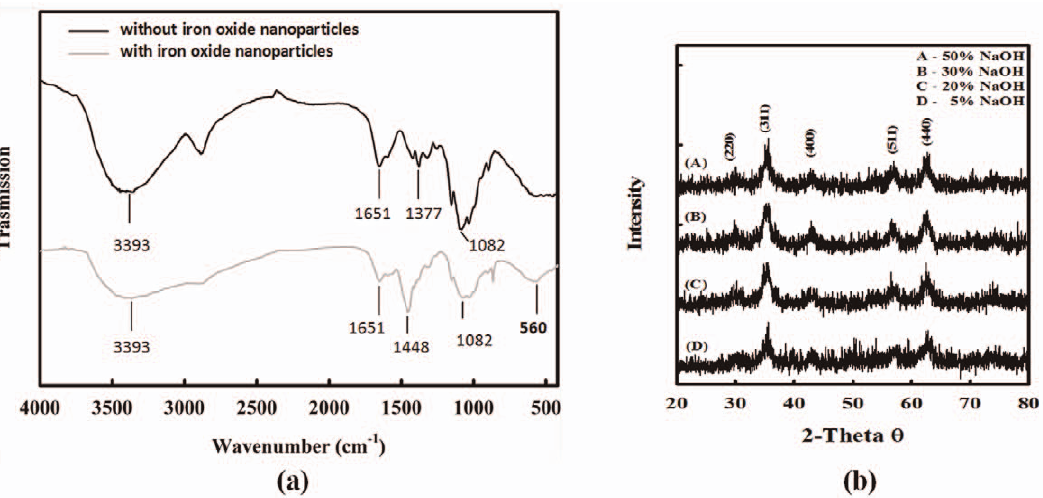
Figure 3. Characterization of the iron oxide-chitosan composite spheres. (a) FTIR spectra of chitosan spheres (gray line) and iron oxide nanoparticle-loaded chitosan spheres (black line). (b) X-ray diffraction pattern from iron oxides nanoparticle-loaded chitosan spheres prepared from the NaOH solutions with various concentrations.